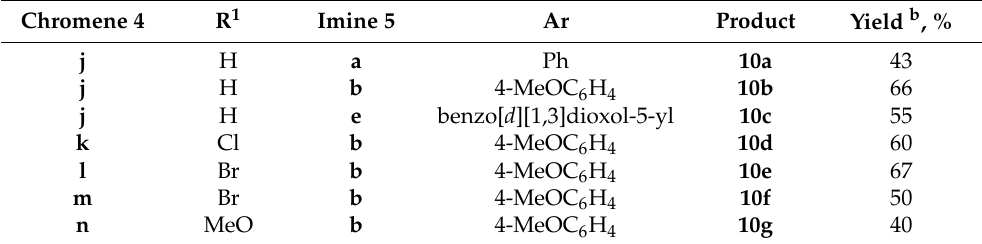
Table 4. Scope of the synthesis of 2-CCl 3 -substituted chromanes 10 a .